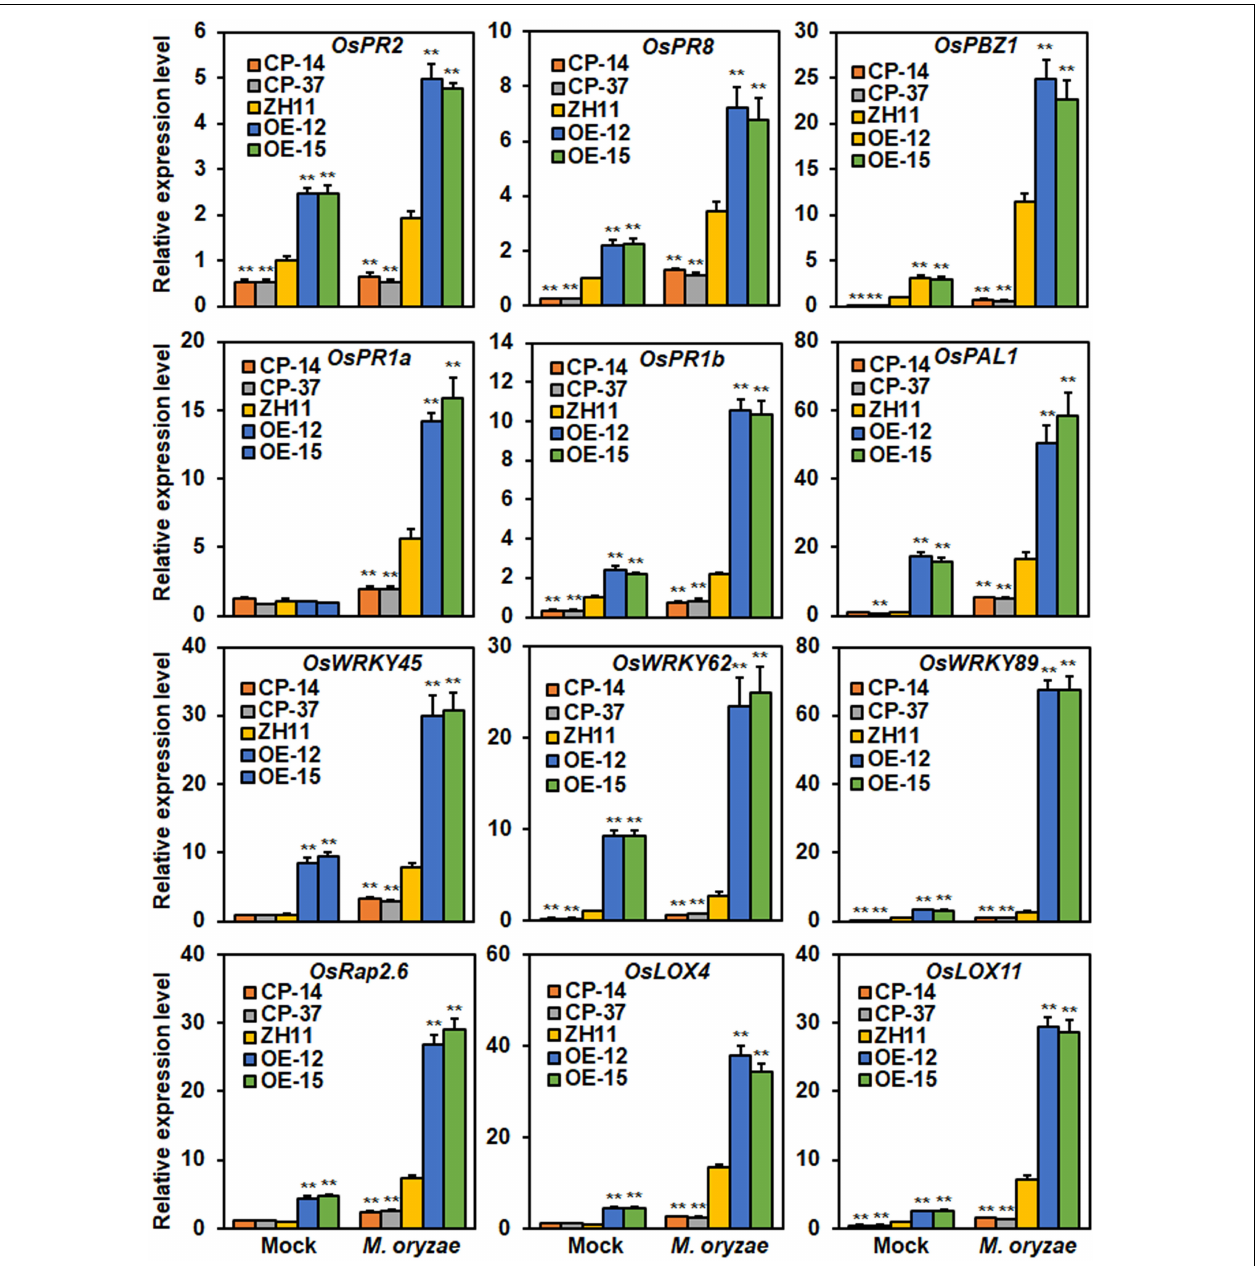
FIGURE 6 | Differentially expression of selected defense and signaling genes in ONAC096 -CP and ONAC096 -OE plants with or without M. oryzae infection. Total RNA was extracted from ONAC096 -CP, ONAC096 -OE and WT plants after infection or non-infection of M. oryzae . Relative expression levels of the defense and signaling genes were normalized to the expression level of the 18s rRNA gene. Experiments were repeated for three times with similar results. Data presented are the means ± SE from three independent experiments and asterisks indicate significant difference ( p < 0.01, Student’s t test) in comparison to